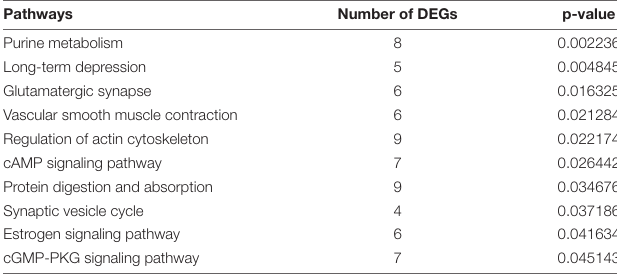
TABLE 3 | Summary of 10 significant metabolism-related signaling pathways. Pathways